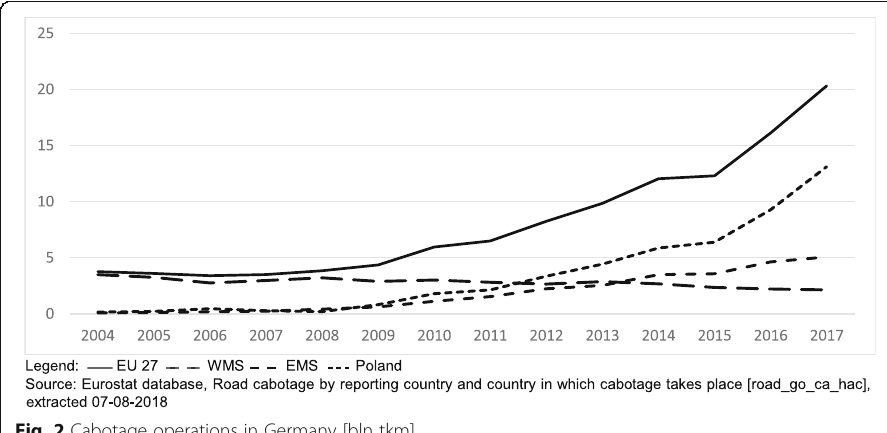
Fig. 2 Cabotage operations in Germany [bln